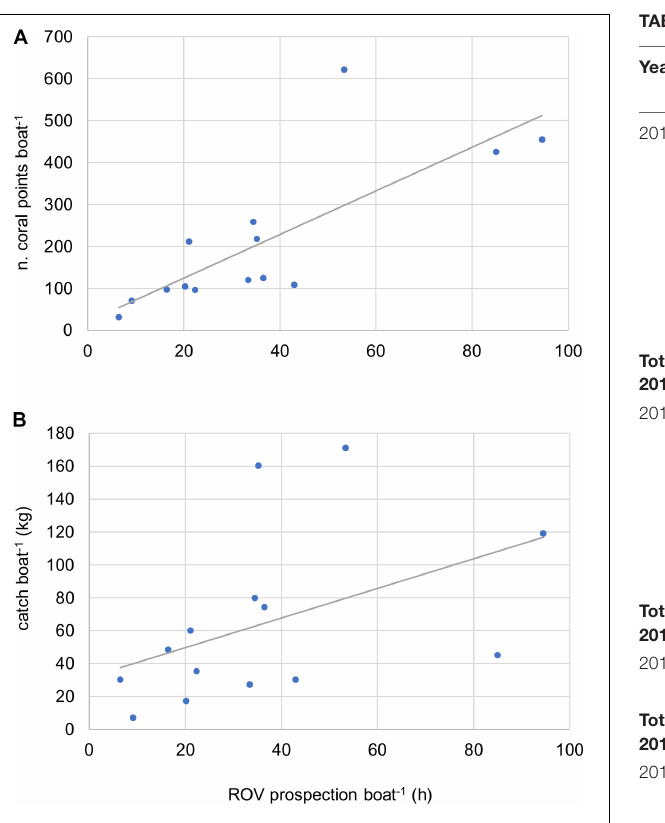
FIGURE 4 | Relationships between hours invested in ROV prospection by each boat in each investigated year (ROV prospection boat − 1 ) and the number of coral points (n. coral points boat − 1 ; n = 14, R = 0.780, P < 0.01) (A) , and the weight of harvested colonies (catch boat − 1 ; n = 14, R = 0.518, P < 0.1) (B)